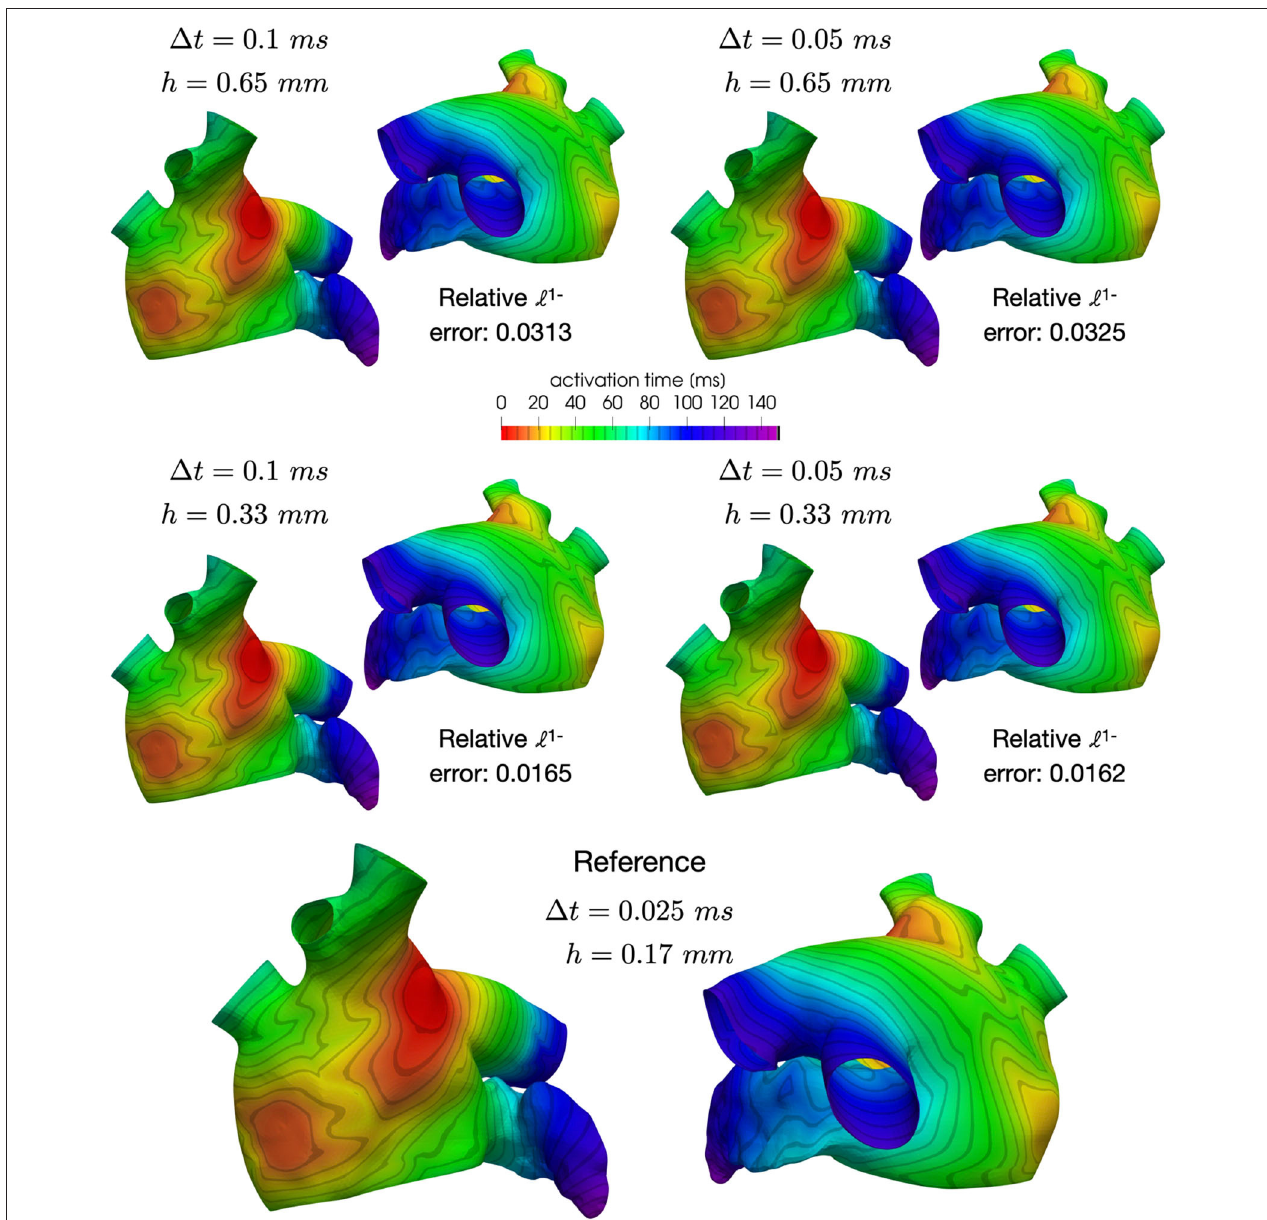
FIGURE 6 | Comparison of activation maps numerically approximated using different space and time